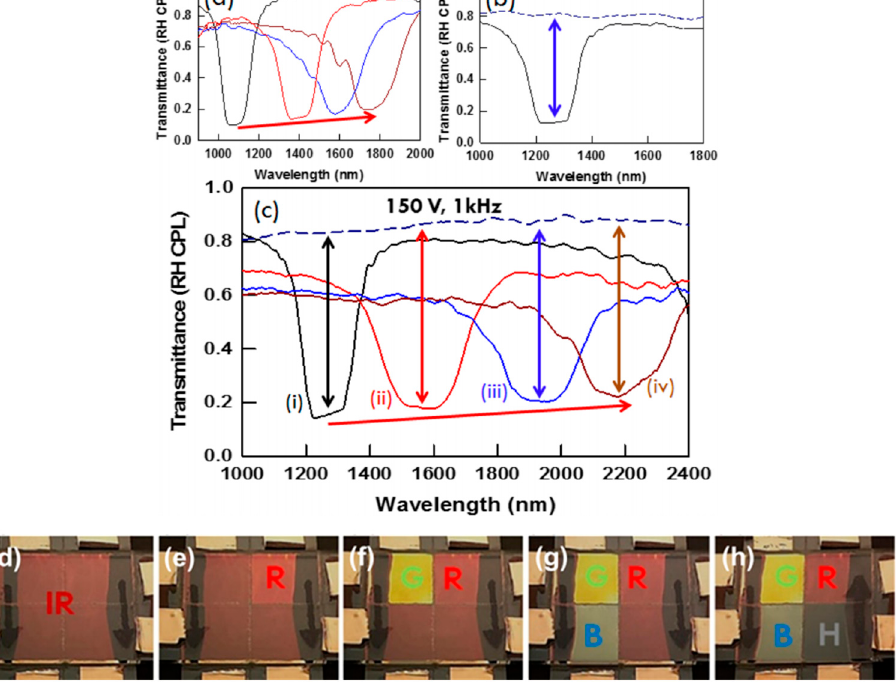
Figure 4. ( a ) Red shifting tuning of the selective reflection of a 15-µm thick PSCLC by the application of DC voltage of 0, 30, 50, and 60 V DC. ( b ) Reflection switching of the PSCLC band gap is induced by the application of 150 V AC. ( c ) Reconfiguration of the selective reflection (tuning and switching) is illustrated in sequential transmission spectra (i) 0, (ii) 40, (iii) 60, and (iv) 70 V DC. Reflection switching of (i–iv) was included with 150 V AC at 1 kHz. The one-sided arrows represent the shift of the reflective band and the vertical double-sided arrows represent the transition between reflective and transparent states. The sample was formulated by mixing 0.4 wt.% I-369, 6 wt.% SL04151, 3 wt.% R1011, and 90.6 wt.% E7 prepared by exposure to a 100 mW cm − 2 365 nm wavelength UV light for 3 min. Control of color in PSCLC optical elements separated into four addressable pixels: ( d ) 0 V (IR), ( e ) 3 V of DC field was applied to the upper right pixel (red), ( f ) 6 V of DC field was concurrently applied to the upper left pixel (green), ( g ) 9 V of DC field was concurrently applied to the bottom left pixel (blue), and ( h ) 250 V of AC field at 1 kHz was applied to the bottom right pixel (homeotropic). Adapted from ref.